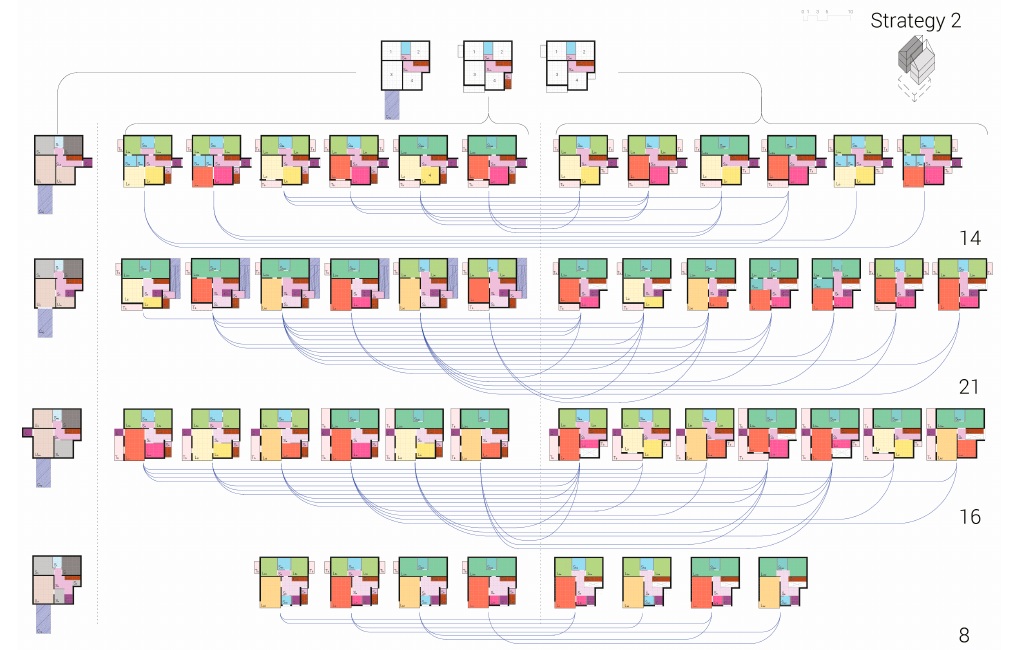
Figure 22. 59 composition variations obtained using Strategy 2 (Ana Bel č i č , 2022).